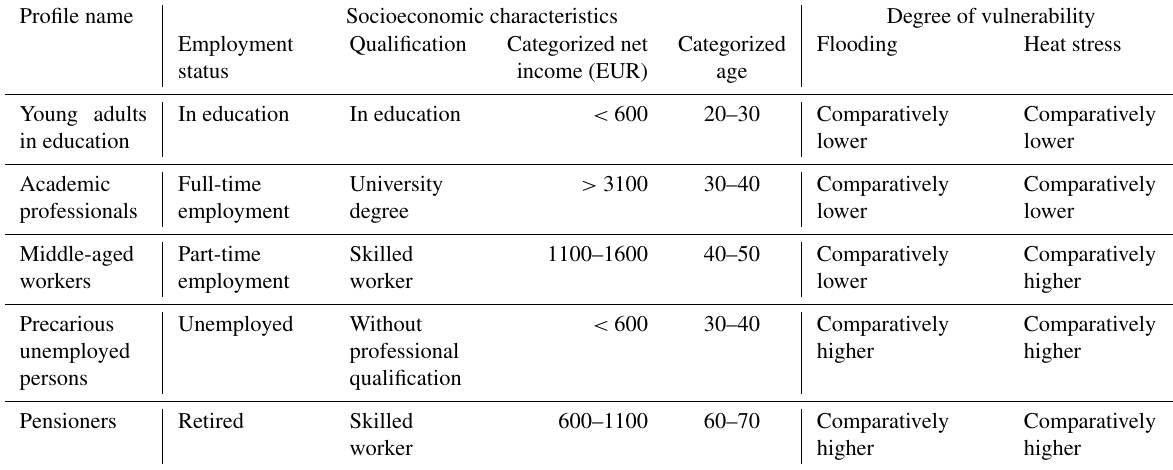
Table 2. Set of household predictors in the form of socioeconomic profiles to represent societal groups differentially vulnerable and/or at